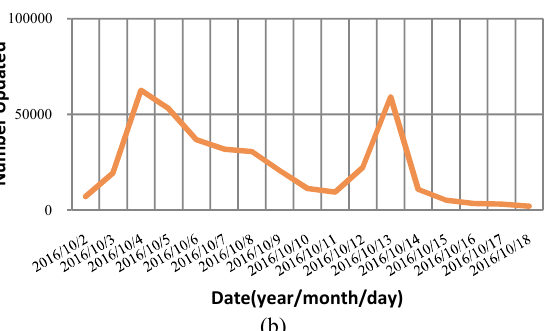
Figure 2. Temporal changes of OSM data updated as roads (a) and buildings